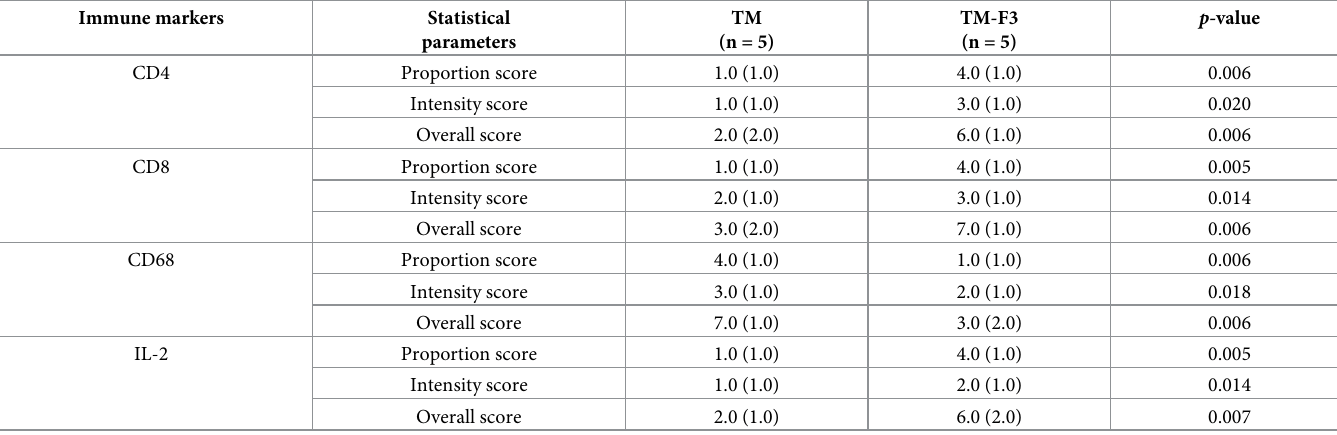
Table 3. Effects of F3 on the expression of immune markers in TM and TM-F3. Immune